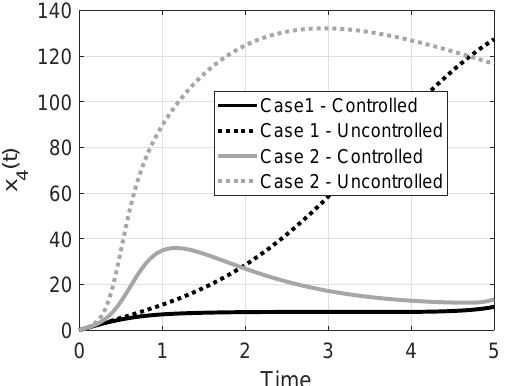
Figure 8. Evolution of the number of x 4 ( t ) subjects in Case 1 (black line) and Case 2 (grey line) with (continuous line) and without control (dotted line).